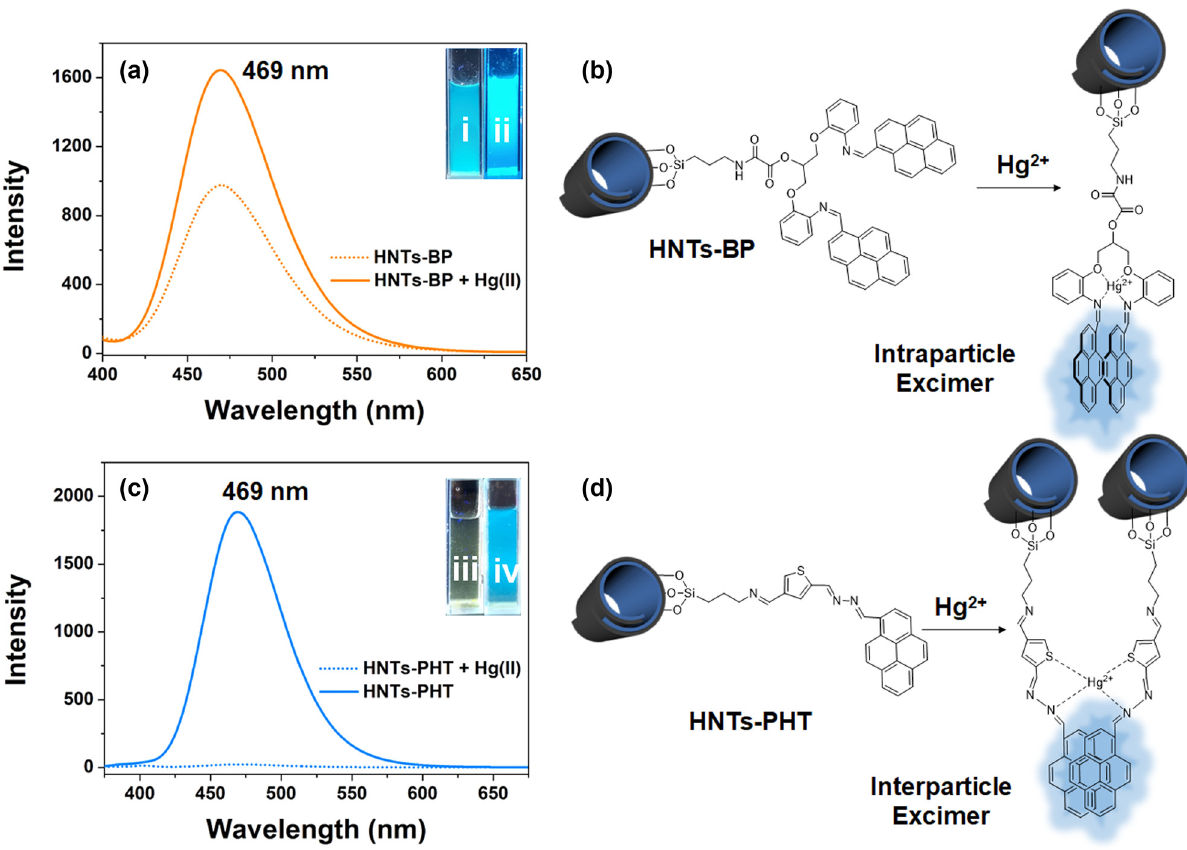
Figure 4: Study on luminescence properties. [( a ) Fluorescence emission spectra of HNTs - BP with ( iv ) or without ( iii ) the addition of Hg ( II ) ; ( b ) mechanism of the Hg ( II )- triggered intraparticle excimer in case of HNTs - BP; ( c ) fl uorescence emission spectra of HNTs - PHT with ( ii ) or without ( i ) the addition of Hg ( II ) ; and ( d ) mechanism of the Hg ( II )- triggered interparticle excimer in case of HNTs - PHT ] .